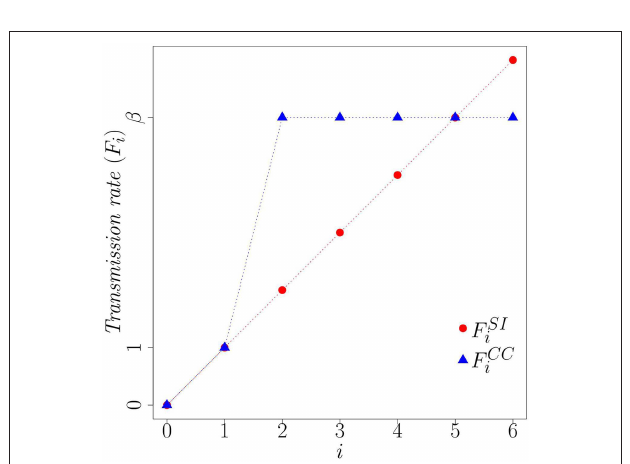
2 , m 6 and C 0 ; (B) moderately clustered network (blue) with = = △ = 4 , m 2 and C 0 . 4 . = = △ =